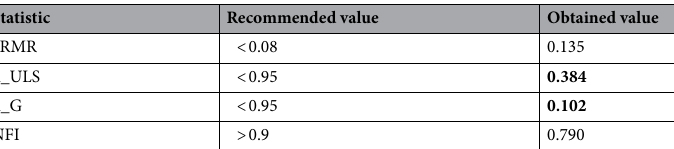
Table 4. Results of overall model fit for the PLS path analysis. SRMR, standardized root mean square residual; d_ULS, unweighted least squares discrepancy; d_G, geodesic discrepancy; NFI, normed fit index. Significant values are in bold.